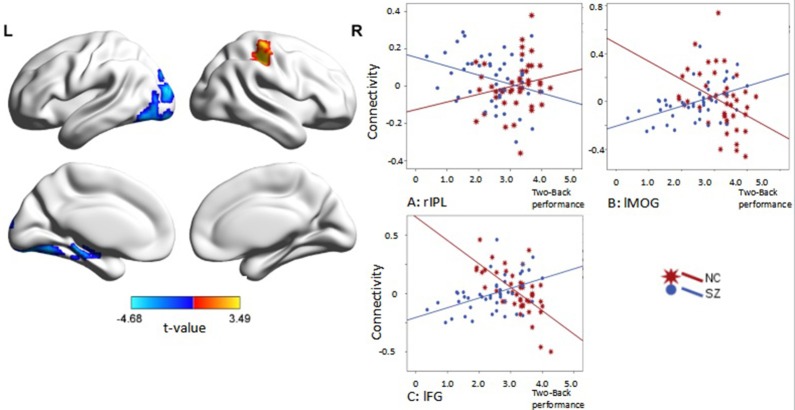
Interaction effect of diagnosis × task performance in psychophysiological interaction analysis using the right DLPFC as the seed region (p < 0.05, corrected, cluster size = 70). Fitted lines between n-back score and connectivity within each group were plotted. rIPL, right inferior parietal lobule; lMOG, left middle occipital lobule; lFG, left fusiform gyrus.